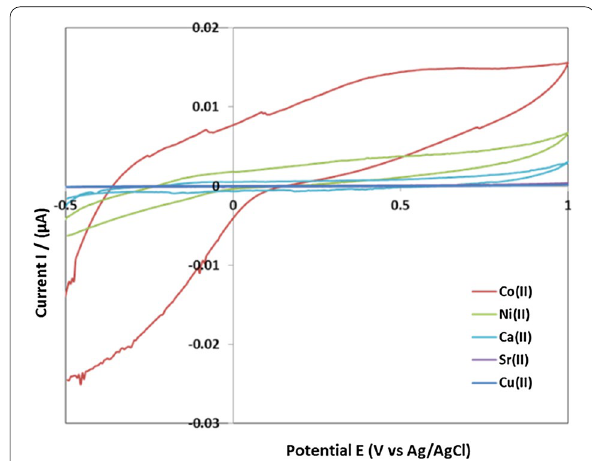
Fig. 8 The cyclic voltammograms of ARLD-5 electrode after adding interfering